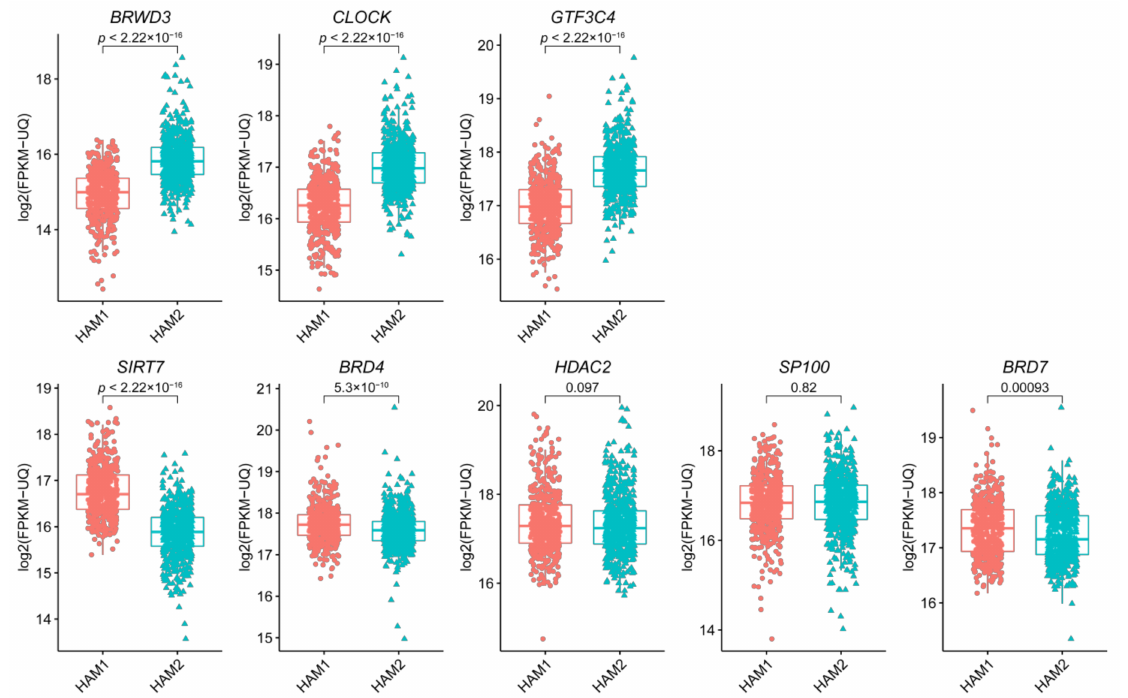
Figure 8. Expression of the eight HAM signature genes in HAM1 and HAM2 groups of patients. All of the eight HAM signature genes, except for HDAC and SP100 , showed significant di ff erential gene expression between HAM1 and HAM2 groups. Genes in the upper row including BRWD3 , CLOCK and GTF3C4 have higher expression in HAM2 group while those in the lower row including SIRT7 , BRD4 and BRD7 are expressed more in HAM1